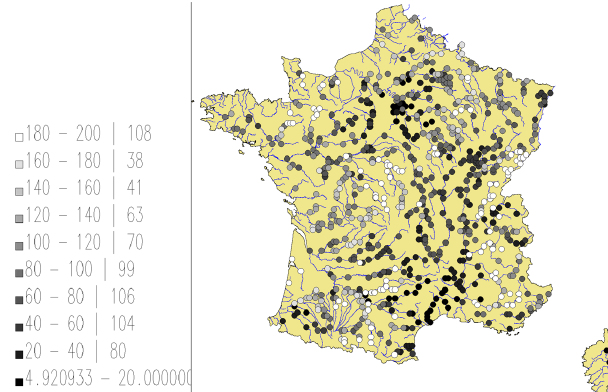
Fig. 3. Return period under climate change associated with the present time 100-yr return period level. The downscaling technique is QM and the future time period is 2035–2064. Increases in return period above doubling (e.g. the probability is divided by more than 2) are figured as doubling. The map is built using GRASS (GRASS- GIS, 2008).